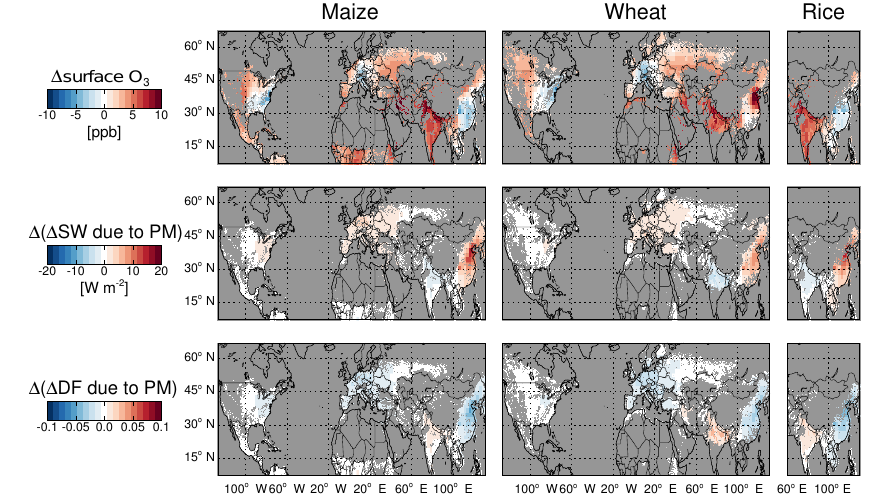
Figure 10. Same as Fig. 5, but for change in quantities using RCP8.5 emissions scenarios (2050 −